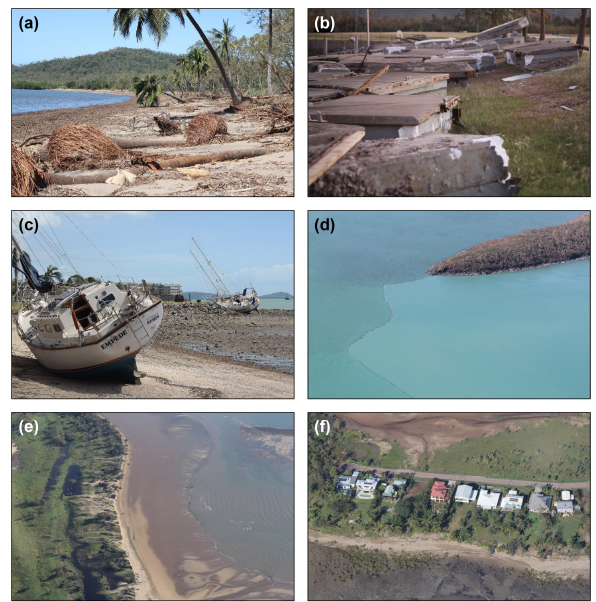
Figure 9. A selection of post- Debbie ground and aerial images. Ero- sion of the beach and dunes at Seaforth (a) ; concrete-clad pontoon displaced on adjacent grassland, providing an inundation marker, at Laguna Quays Marina (b) ; yachts stranded on Airlie Beach (c) ; brackish river runoff meeting seawater causing flocculation around Hamilton Island (d) ; an example of natural barrier overwash and pooling (e) and the contrasting exposure of some residential prop- erty to coastal processes (f) , when development occurs within these natural overwash zones. Authors’ own